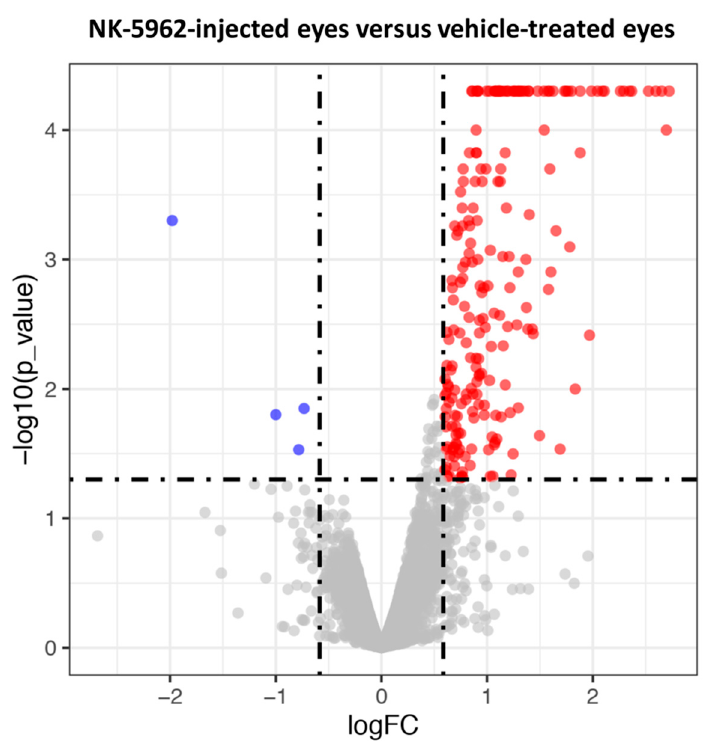
Table 2. Down-regulated genes in NK-5962-treated retinas.